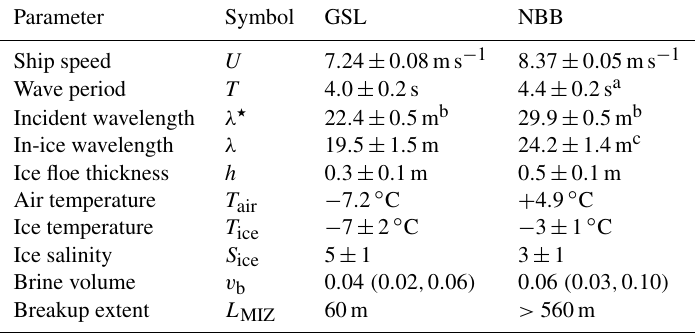
Table 1. Wave and ice parameter values measured, estimated or calculated for both experiments as well as their associated uncertainties. Values in parentheses indicate extreme values whenever they are not equidistant from the mean. Parameter